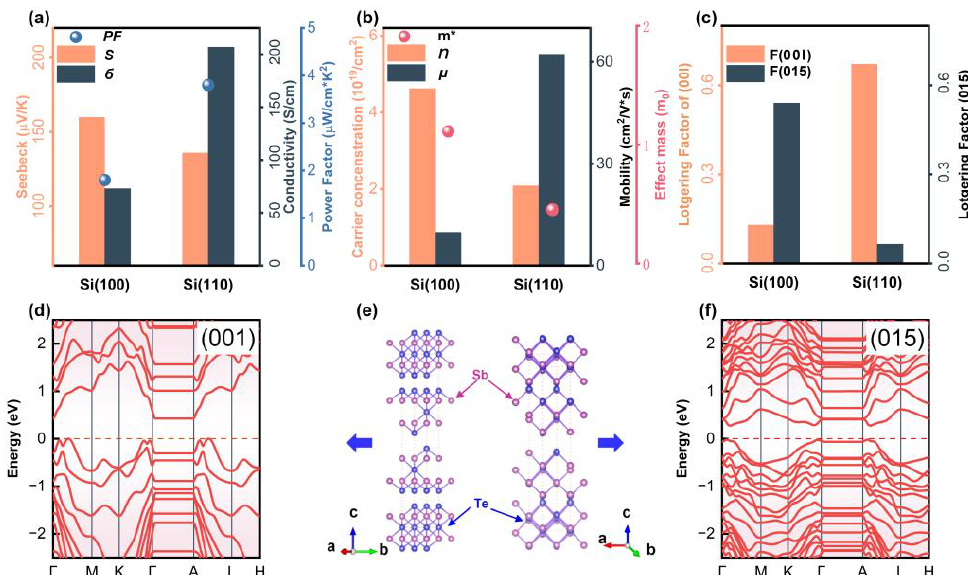
Figure 4. ( a ) Seebeck coefficient S , electrical conductivity,  and power factor PF ; ( b ) Carrier concen- tration n , mobility μ and m* ( c ) F (015), F (00 l ) of Si(100), and Si(110) thin films. ( d , f ) Electrical band structures of ( e ) two crystal models of Sb 2 Te 3 based on the electrical transport along planes (00 1 ) and